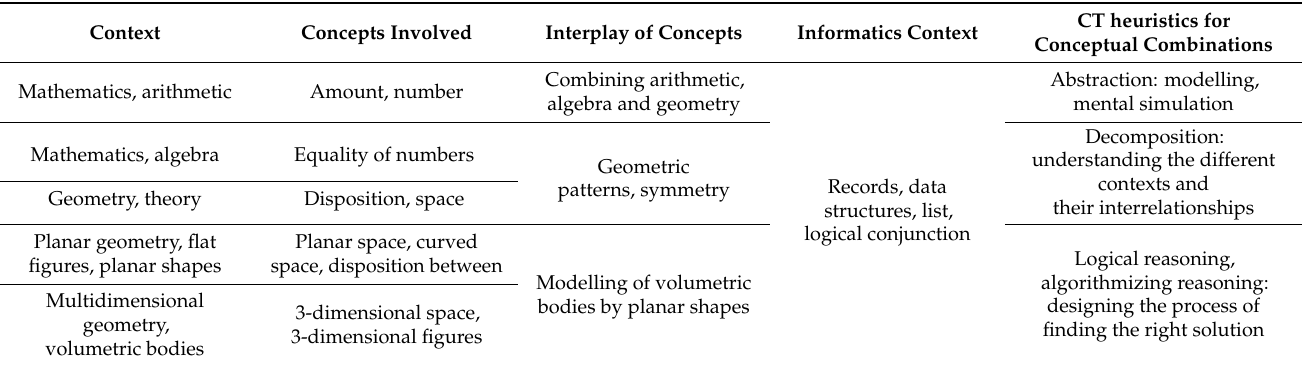
Table 5. Example of CT-driven mindset on pattern matching within the Bebras short task solving framework (elaborated by the